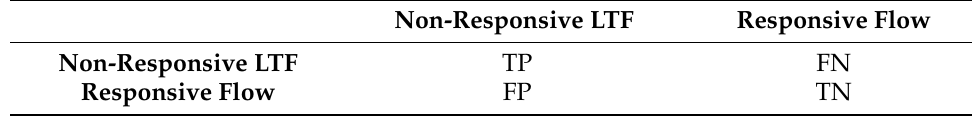
Table 2. Confusion